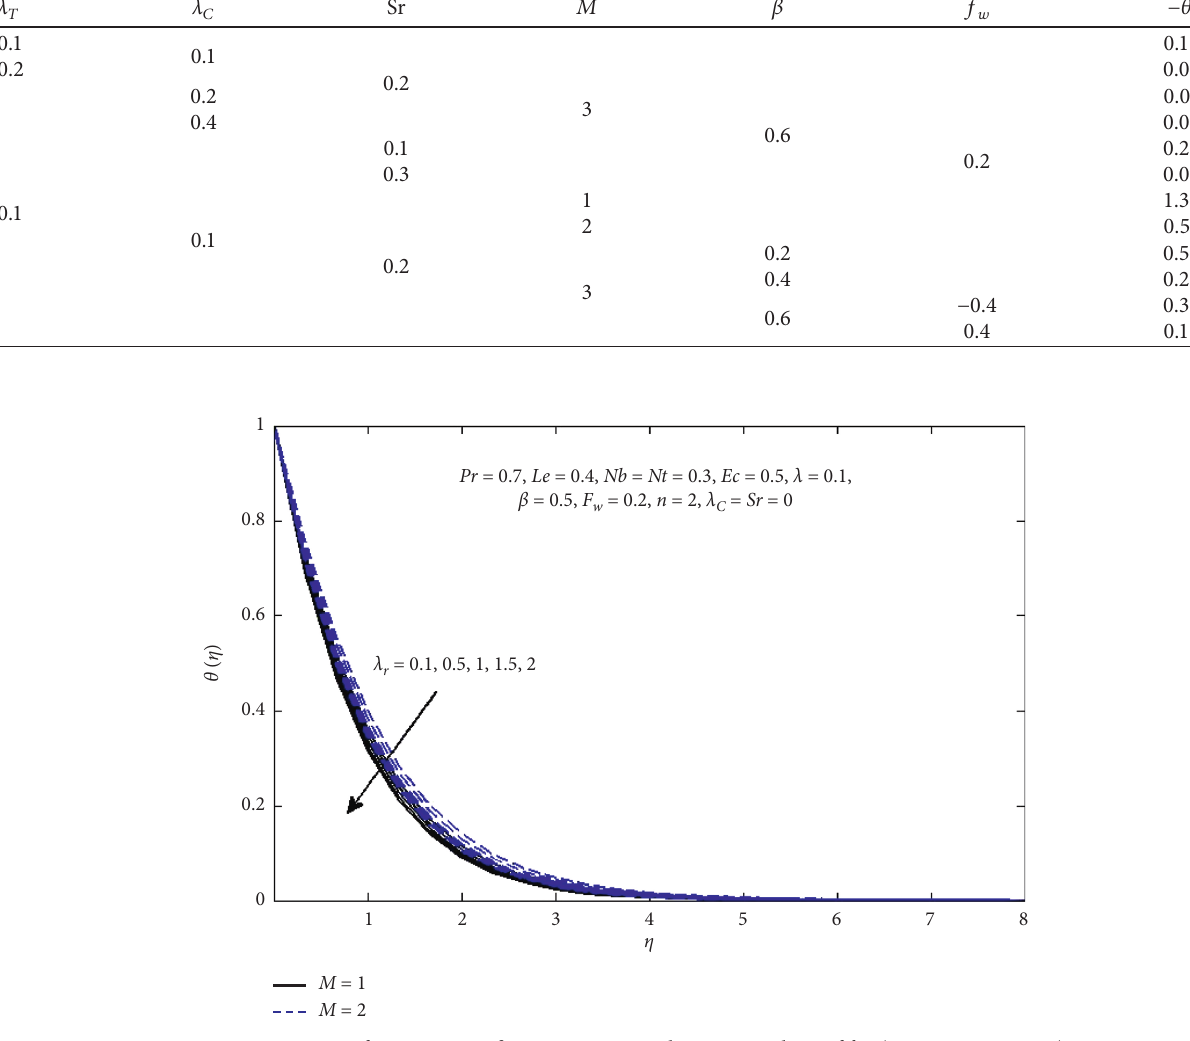
Table 2: Heat transfer rate at the sheet for numerous values of Sr , λ